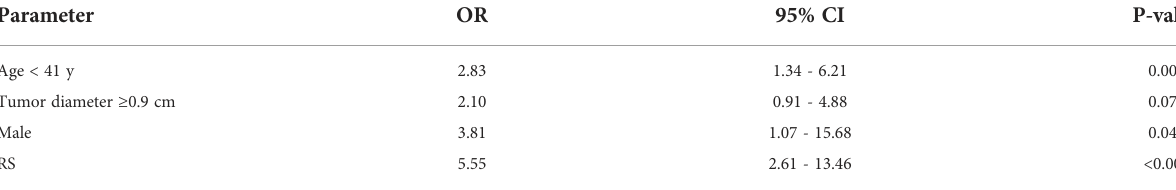
TABLE 4 Multivariable analysis of clinical features and RS for predicting in PTC patients with HT in the training dataset. Parameter